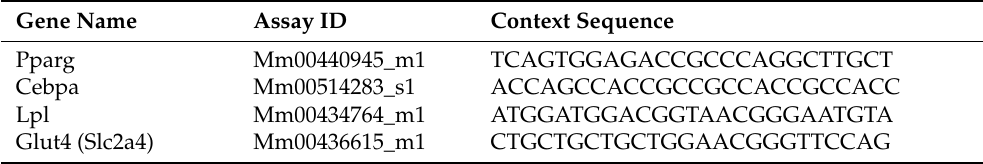
Table 3. Primer/probe gene expression assays purchased for real time qPCR from Applied